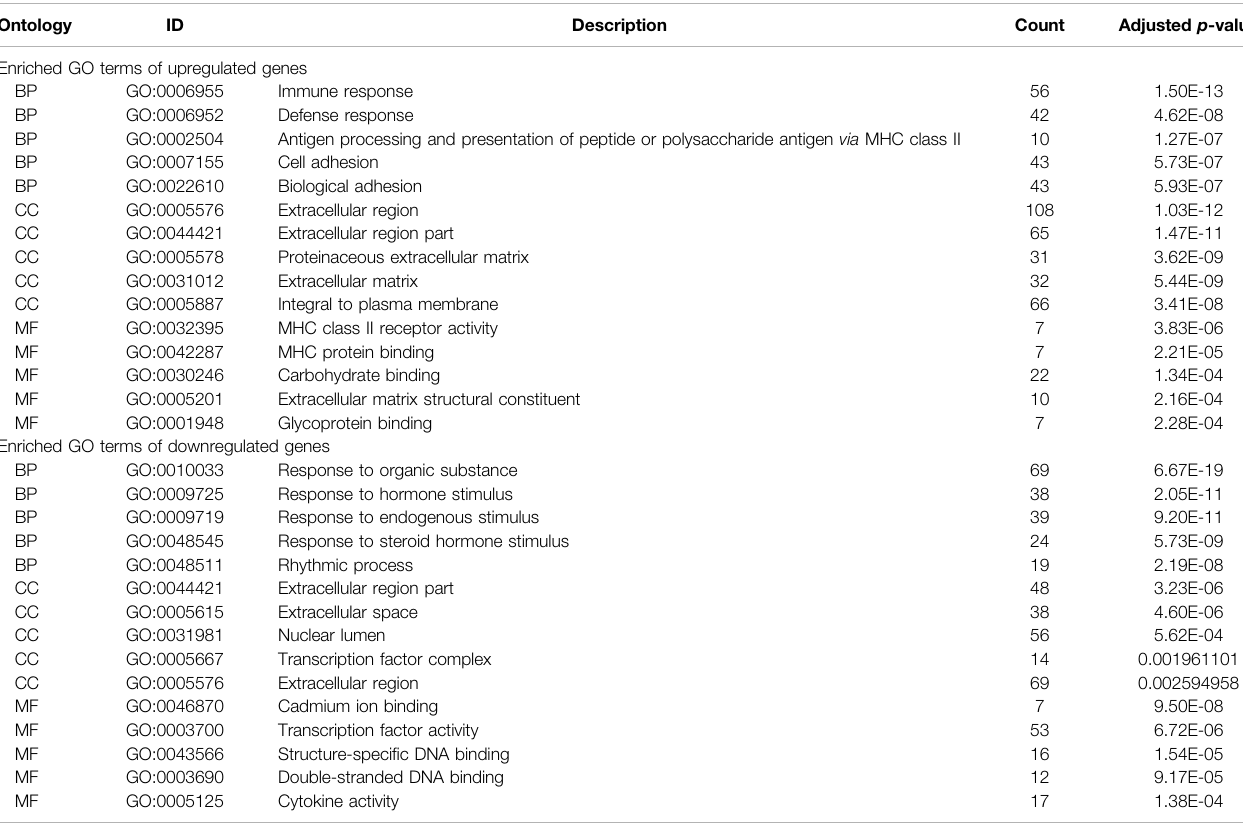
TABLE 1 | Enriched GO terms of upregulated and downregulated expressed genes. Ontology